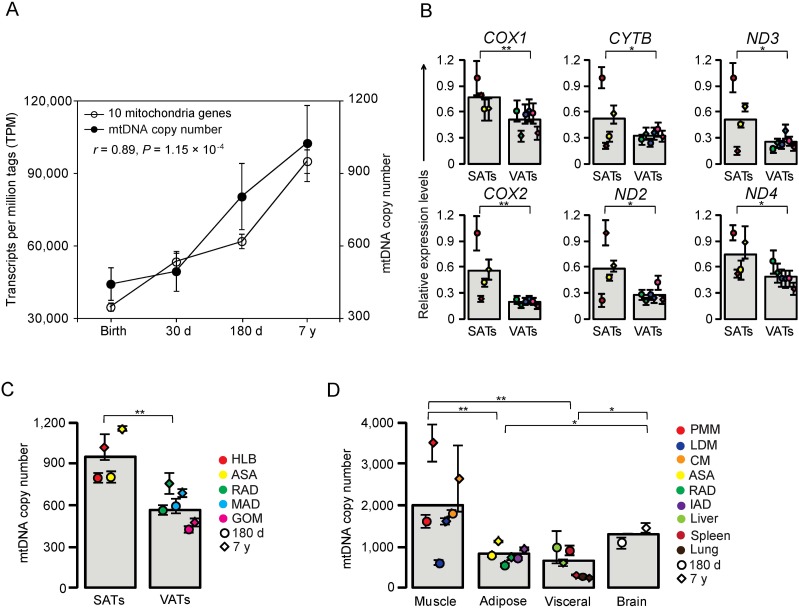
Analysis of mitochondrial genes.(A) Correlation of mitochondria genes expression and DNA copy number. Data are means ± SD. The Pearson correlation coefficient (r) and the corresponding significance value (P) were shown. (B) Comprehensive survey of development stage- and tissue-specific expression patterns of mitochondrial genes. SAT, subcutaneous adipose tissue; VAT, visceral adipose tissue; COX1, cytochrome c oxidase 1; COX2, cytochrome c oxidase 2; CYTB, cytochrome b; ND2, NADH dehydrogenase 2; ND3, NADH dehydrogenase 3; ND4, NADH dehydrogenase 4. (C) Comprehensive survey of development stage- and tissue-specific mitochondria copy number in various types of adipose tissues. (D) Comprehensive survey of development stage- and tissue-specific mitochondria copy number in various types of tissues. Data are means ± SD. The significance of differences between samples was determined by Student’s t-test (*: P < 0.05; **: P < 0.01).